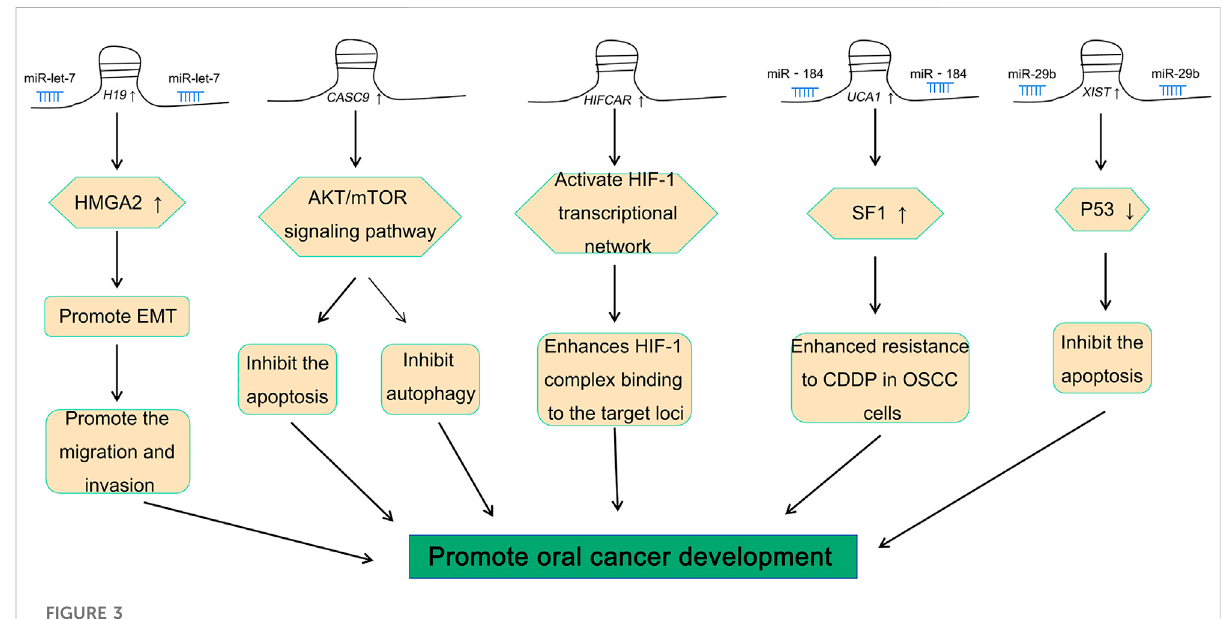
FIGURE 3 Role of H19 , CASC9 , HIFCAR , UCA1 , and XIST in oral cancer.